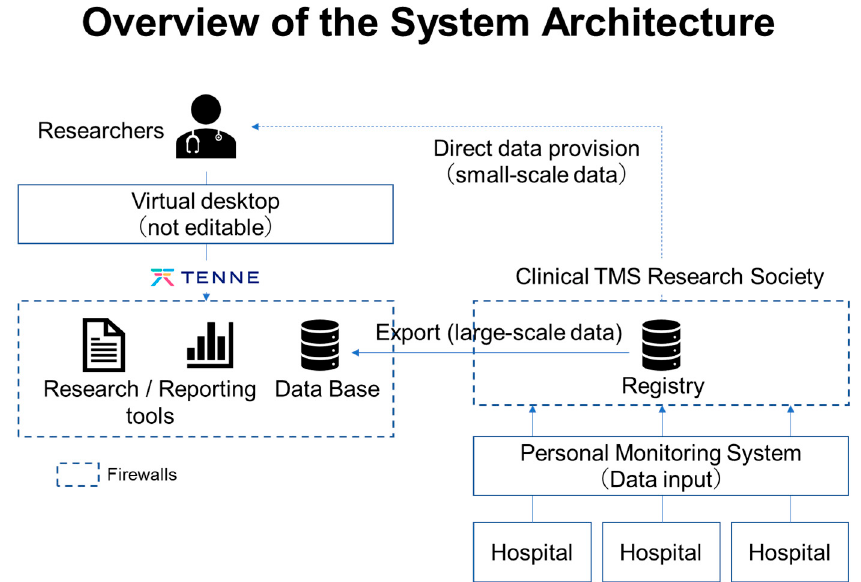
Figure 4. Overview of the System Architecture. TMS-therapy-related data collected from each collaborating medical institution via the Personal Monitoring Systems will be anonymized and stored in a cloud-based database managed by the Japan Society for Clinical TMS Research. In addition, a partner company, TENNE Inc., will handle the system maintenance and operational management.